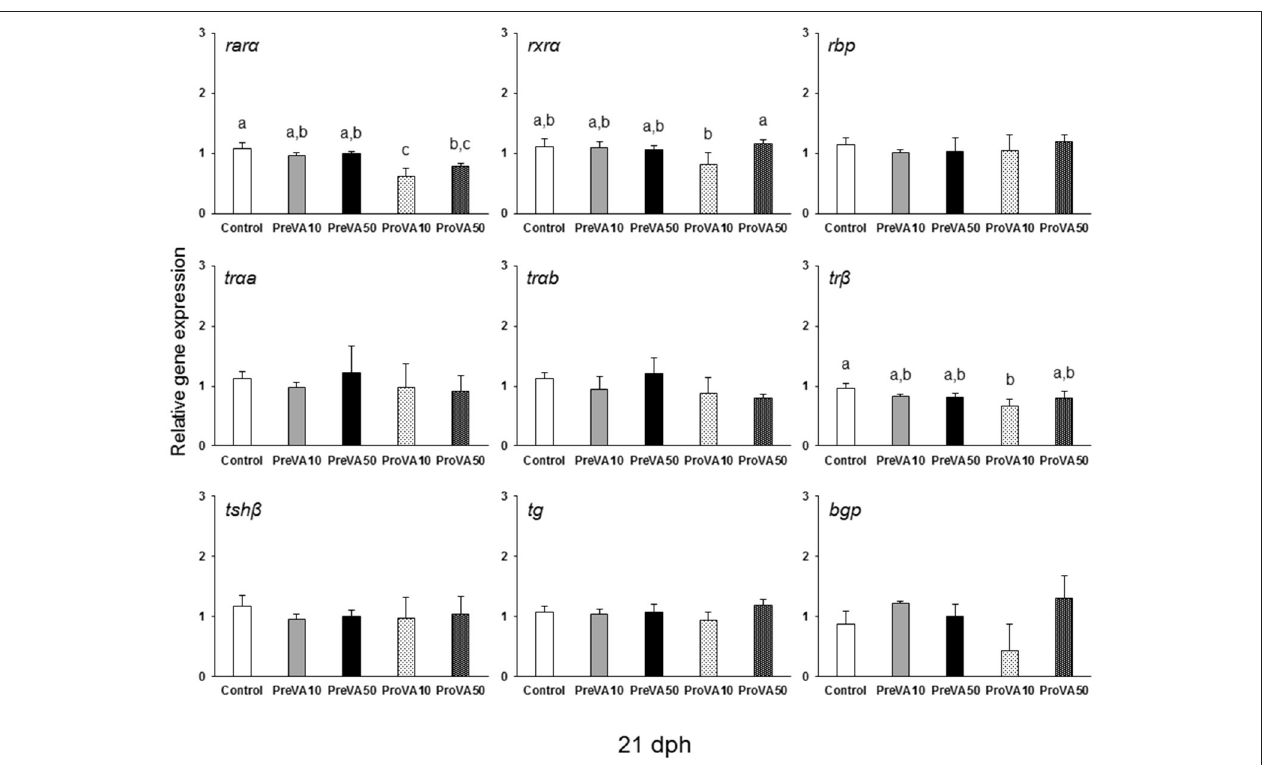
FIGURE 11 | Expression of selected genes related with vitamin A, thyroid hormone and extracellular matrix mineralization in Senegalese sole larvae at 21 dph when fed with increased dietary vitamin A levels during pre- or pro-metamorphosis. rar α , retinoic acid receptor α ; rxr α , retinoid x receptor α ; rbp, retinol binding protein; tr α a, thyroid hormone receptor α a; tr α b, thyroid hormone receptor α b; tr β , thyroid hormone receptor β ; tsh β , thyroid stimulating hormone β ; tg, thyroglobulin; bgp, bone gla protein . For a detailed description about the different experimental groups, please see the legend of Figure 1 . Different letters at the top of each bar denotes statistically significant differences among experimental groups (ANOVA, P < 0.05; N =